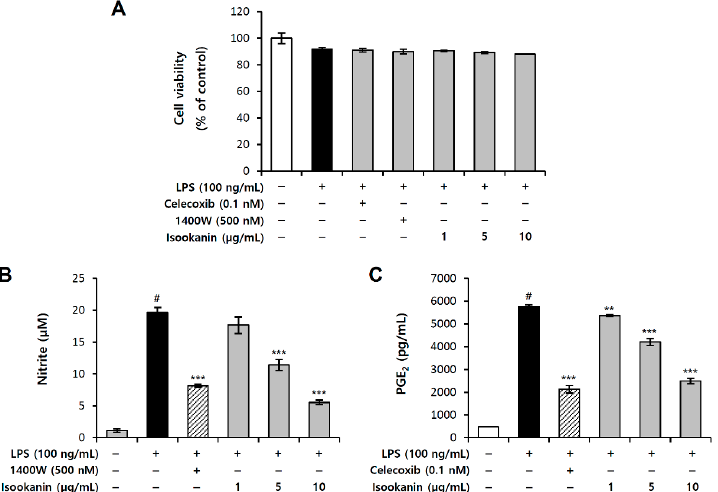
Figure 3. Inhibitory effect of isookanin on NO and PGE 2 production in LPS-induced RAW 267.4 cells. Cells were pretreated with the indicated concentrations of isookanin or positive control for 2 h, before incubation with LPS (100 ng/mL) for 24 h. ( A ) Cell viability was measured using the WST-1 assay. ( B ) The levels of NO in the culture medium were measured using the Griess reaction. ( C ) The levels of PGE 2 in the culture medium were measured using an enzyme-linked immunosorbent assay (ELISA) kit. The results are mean ± standard deviation (SD) ( n = 3). # p < 0.01 vs. LPS-untreated control. ** p < 0.01, and *** p < 0.001 vs. LPS-treated control.